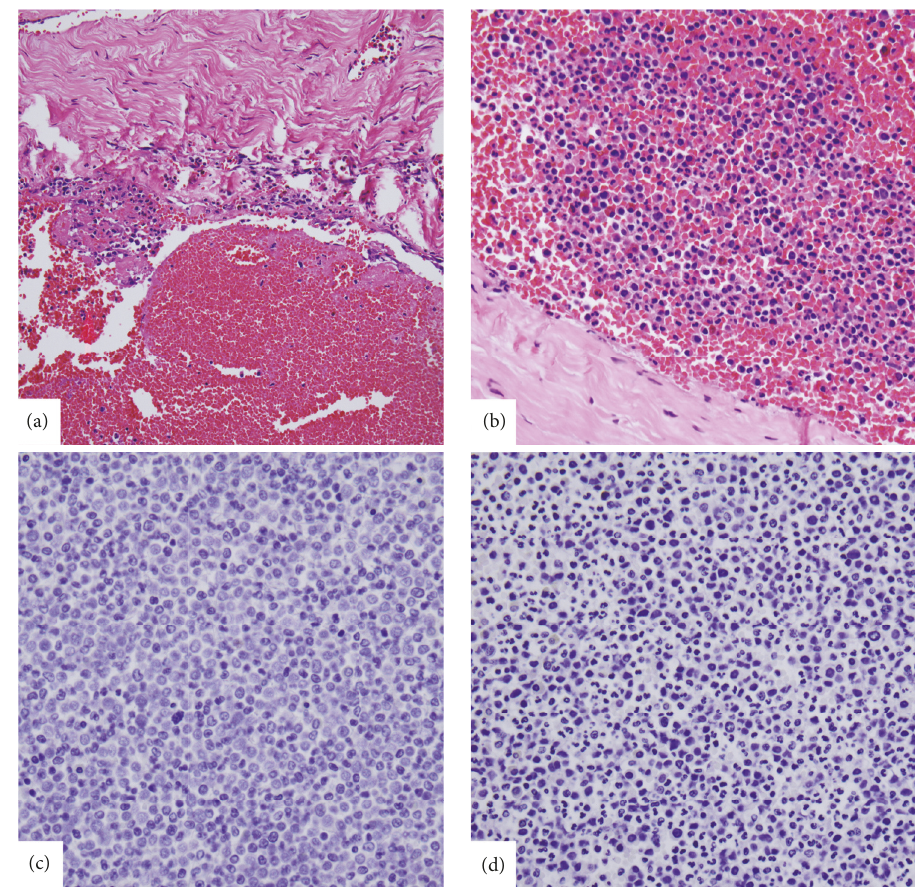
Figure 5: Photomicrographs: low-power (a) and high-power (b) H&E stains showing lymphocytic invasion throughout the subdural space. Panels (c) and (d) show confluent immature myeloblasts consistent with myeloid